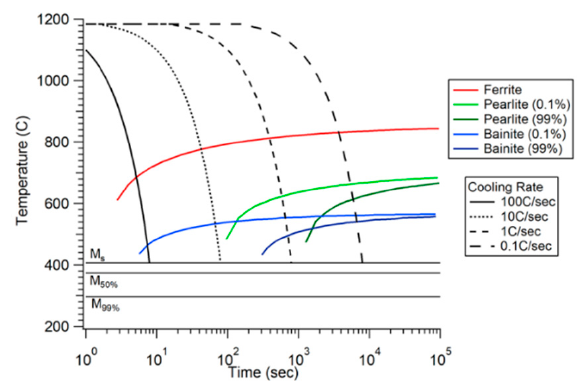
Figure 11. Continuous Cooling Transformation (CCT) diagrams for 0.1 wt% C. The CCT diagram is used to understand the evolution of the microstructure on cooling from face centered cubic (FCC) austenite. Drawn using the thermodynamic software JMatPro ® .